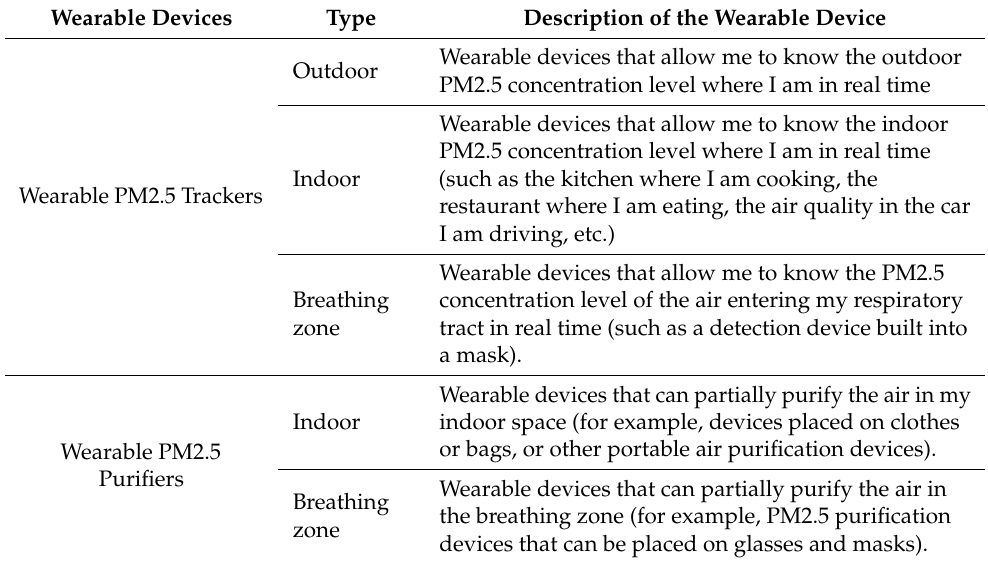
Table 2. Wearable PM2.5 devices investigated in the